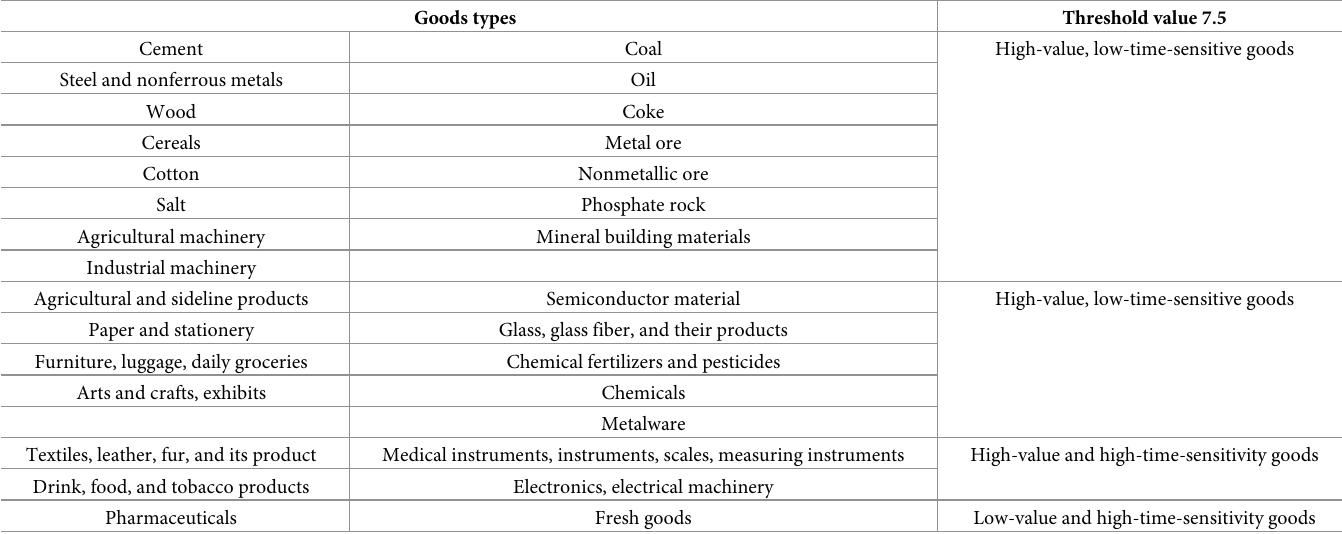
Table 3. Classification of railway transportation goods.